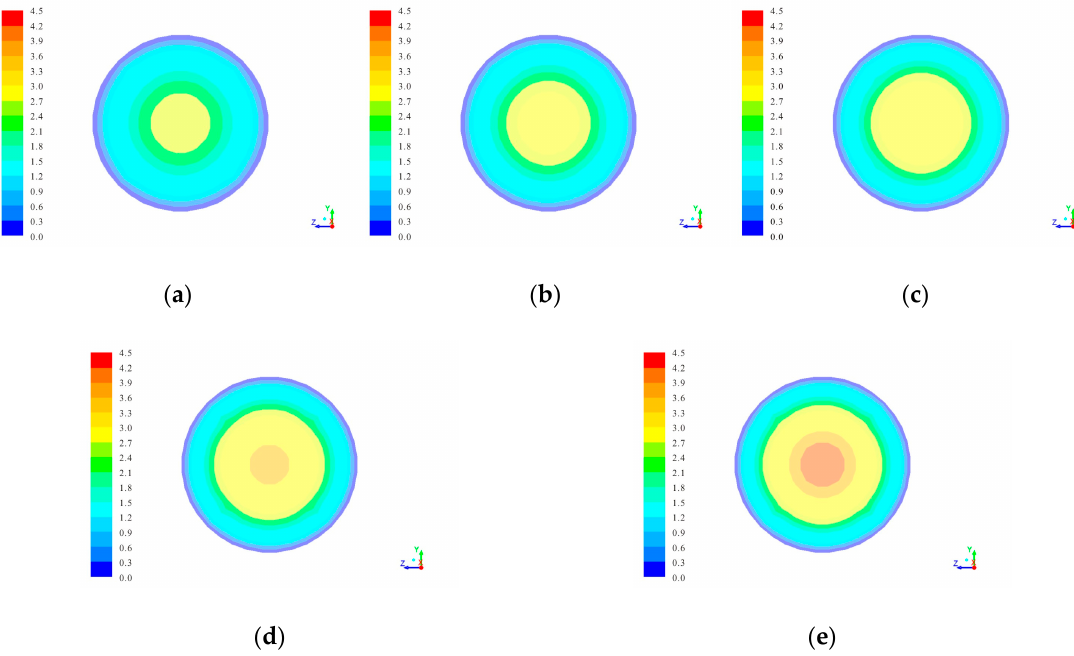
Figure 6. Velocity distribution contours with 76.05% solid concentration of CGFB slurry at different feeding velocities through the straight pipe: ( a ) 1.4 m/s; ( b ) 1.6 m/s; ( c ) 1.8 m/s; ( d ) 2.0 m/s; ( e ) 2.2 m/s.